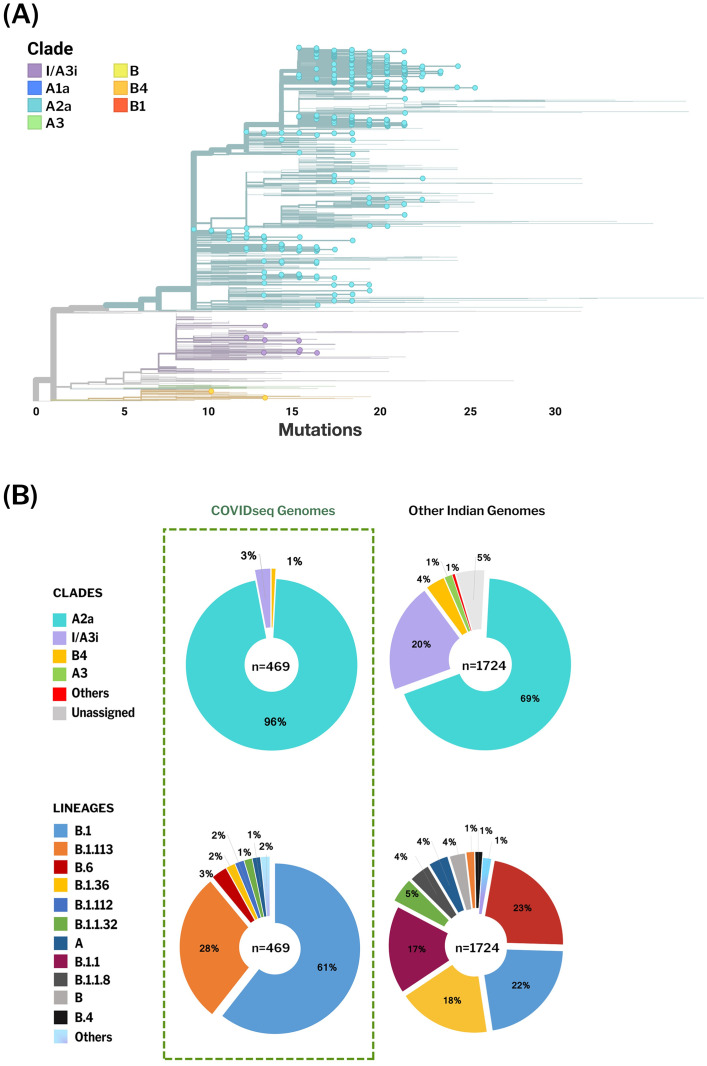
Phylogenetic distribution of Indian SARS-CoV-2 genomes.A) Phylogenetic trees generated by Nextstrain. 469 COVIDseq genomes reported from this study are highlighted. The 469 genomes cluster under clade A2a, I/A3i and B4, with A2a being the dominant clade. B) The proportion of clades and PANGOLIN lineages representing the Indian genomes. B.1 and B.1.113 are the dominant lineages in COVIDseq genomes whereas other Indian genomes show a dominance of B.6 and B.1 lineages.